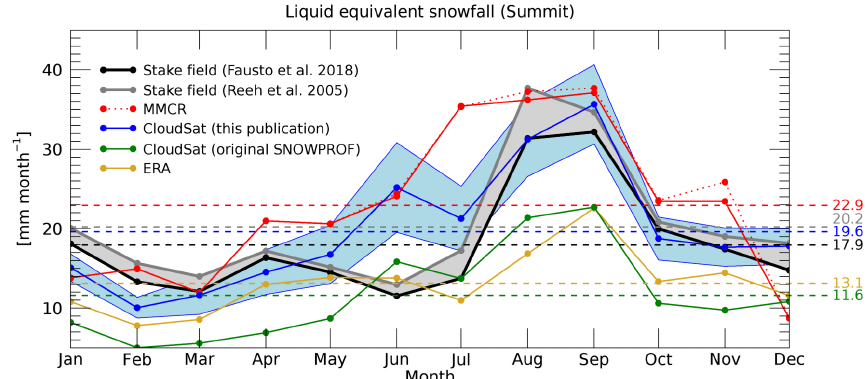
Figure 20. Liquid equivalent snowfall over Summit from different data sources used in this publication. The shaded uncertainty range around the CloudSat estimate gives the uncertainty due to Z – S relation. The shaded uncertainty range around the stake field estimates gives the uncertainty due to different assumption about snow density. The stake field estimates presented herein have been corrected for sublimation/deposition using ERA-Interim sublimation/deposition estimates. For MMCR we used the KB09_LR3 Z – S relation (see Table